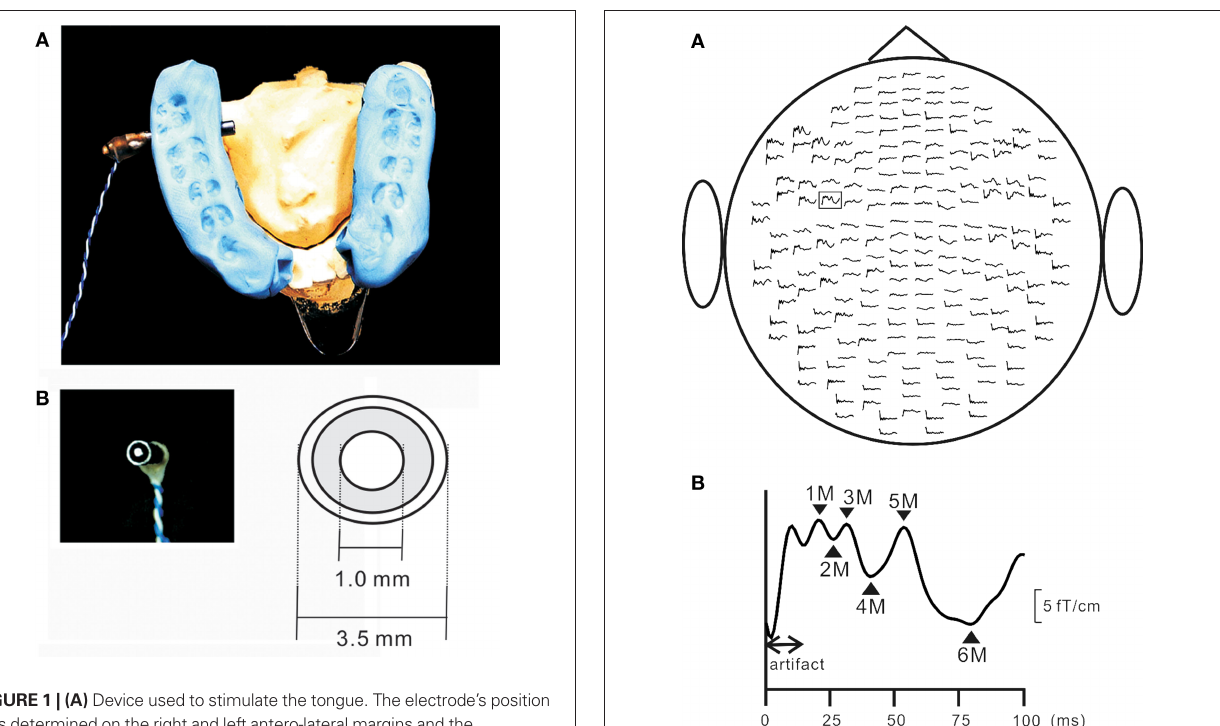
FIGuRE 1 | (A) Device used to stimulate the tongue. The electrode’s position was determined on the right and left antero-lateral margins and the postero-lateral margins of the tongue around foliate papillae by using the device. (B) The surface structure of the concentrated bipolar electrode used to stimulate the tongue. Adopted from Sakamoto et al.